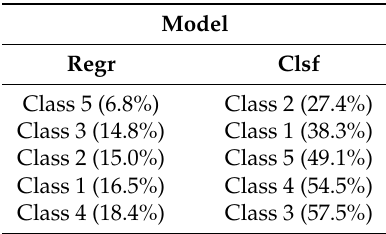
Table 6. Performance from the best to the worst ranking of ML models in the EP grouped by functional road class with energetic deviation in brackets for the LBCS problem scenario and the ATC test